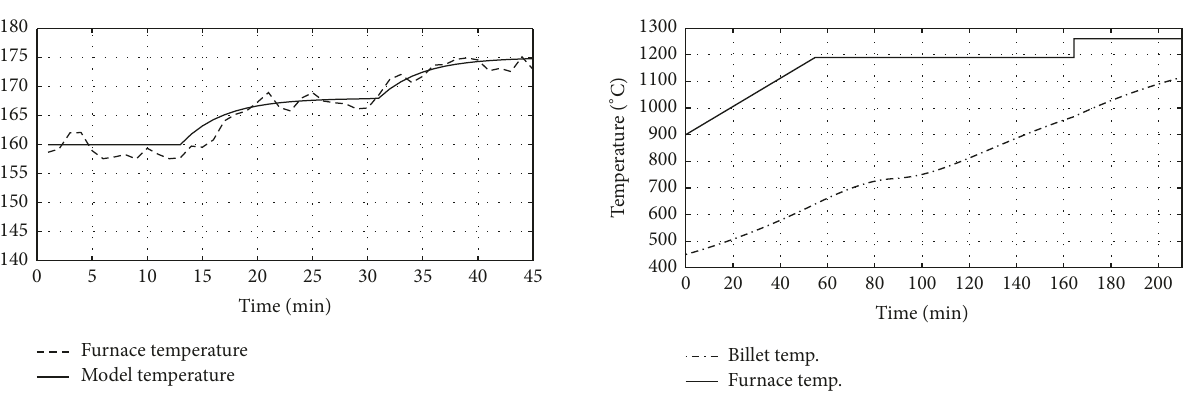
Figure 4: Furnace internal temperature and temperature of the billet during reheating.